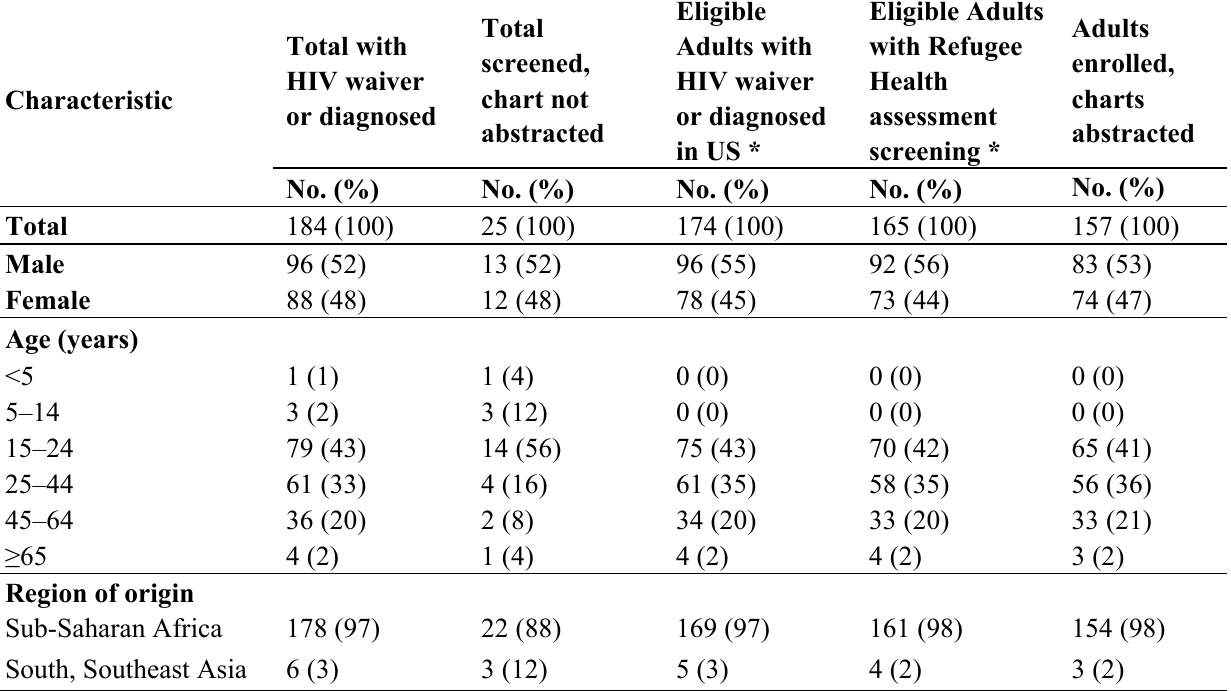
Table 1. Demographic Characteristics of 184 Refugees Diagnosed with HIV Infection, and 157 HIV-Infected Refugees with Medical Chart Review for 2000–2007,